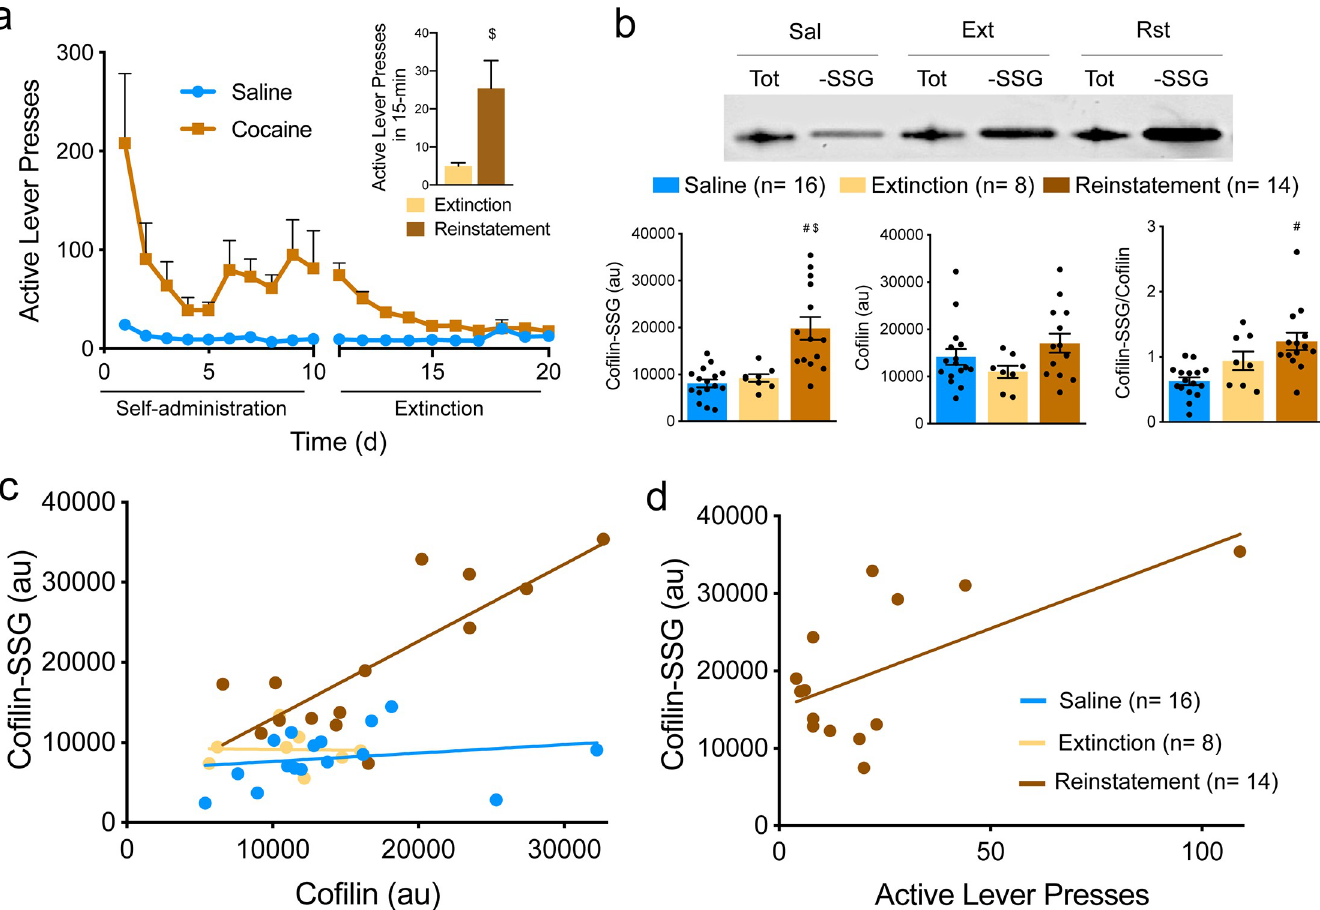
Fig 3. Cofilin S-glutathionylation is increased during 15-minutes of cue-induced cocaine seeking in the absence of cocaine. (a) Active-lever presses during cocaine self-administration and extinction training (n = 16, Saline; n = 22, Cocaine; effect of treatment p < 0.0001 by 2-way ANOVA, F (19, 709) = 51.85). 15-min of cue exposure elevated lever pressing relative to the first 15-min of the final extinction session the day prior (inset; $ p = 0.01 by Student’s t-test). (b) Western blot showing total cofilin (T) and S-glutathionylated cofilin (-SSG) in nucleus accumbens extracts from yoked saline (Sal), extinguished (Ext) and reinstated (Rst) animals with quantification below. Levels of S-glutathionylated cofilin are significantly increased during 15-min of cued reinstatement (F (2, 32) = 12.66, p < 0.001; p > 0.999, Saline vs. Extinction; $ p = 0.001, Extinction vs. Reinstatement; # p < 0.001, Saline vs. Reinstatement by one-way ANOVA followed by Tukey’s multiple comparisons test; n is shown in legend), although levels of cofilin were unchanged (p = 0.110 by one-way ANOVA). Cofilin-SSG was significantly elevated when normalized to total cofilin from the same animal (F (2, 32) = 0.99, p = 0.004; p = 0.355, Saline vs. Extinction; p = 0.215, Extinction vs. Reinstatement; # p = 0.003, Saline vs. Reinstatement by one-way ANOVA followed by Tukey’s multiple comparisons test). See S2 Fig for full Western blots. (c) Relationship between levels of S-glutathionylated cofilin and total cofilin in nucleus accumbens extracts from yoked saline (blue), cocaine extinguished (yellow) and cue-reinstated (brown) rats. In reinstated, but not extinguished or yoked saline animals, increased levels of cofilin S-glutathionylation correlate significantly with levels of total cofilin (p = 0.327, r 2 = 0.087, Saline; p = 0.941, r 2 = 0.001, Extinction; p = 0.001, r 2 = 0.635, Reinstatement) indicating a protective effect of the modification. (d) Active lever presses during a 15-minute cued reinstatement session correlate positively with levels of cofilin-SSG (p = 0.019, r 2 = 0.381). Similar levels in high pressers indicate a potential ceiling effect on cofilin S-glutathionylation. Data are presented as mean ± s.e.m. in (a,